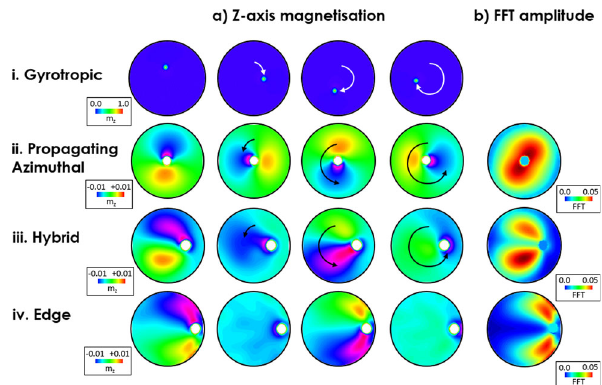
Fig. 2 Dynamic modes in magnetic vortices. a The different modes present in magnetic vortices depending upon the position of the vortex core. Images show the magnetization along the z -axis, m z , calculated with micromagnetic simulations at four different times during the mode excitation and b the fast Fourier transform (FFT) amplitude of the respective